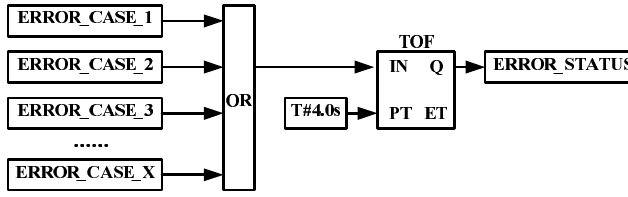
Figure 4. The control logic of triggering the fault(error) status for WTs.